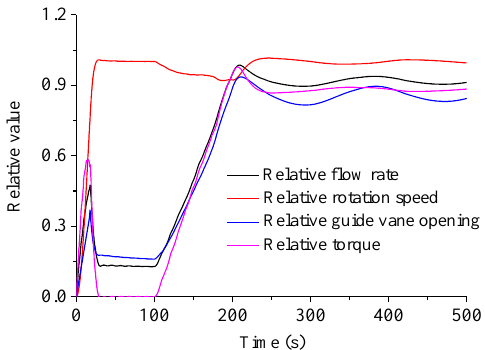
Figure 4. The relative flow rate, relative speed, relative guide vane opening, and relative torque changes of the unit under the lowest head start-up.